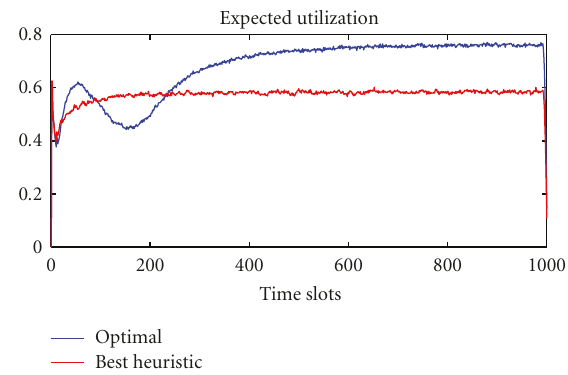
Figure 9: Average utilization over time for both the optimal and heuristic channel selection algorithms. Only the optimal algorithm is guaranteed to eventually converge to the best channel.